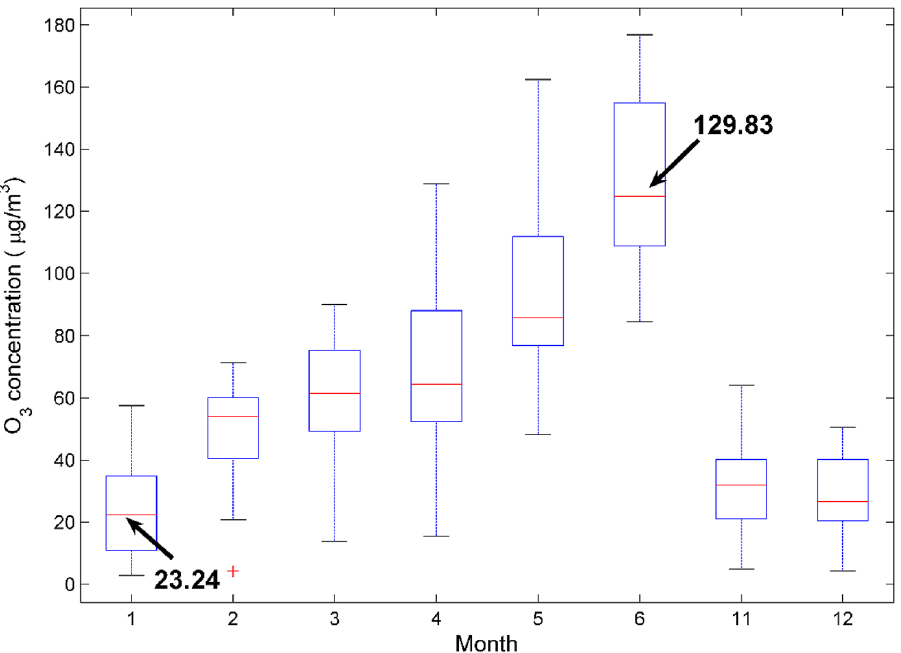
Figure 2. Compare the concentration of O 3 in national control points monthly. Note that there is no data from July to